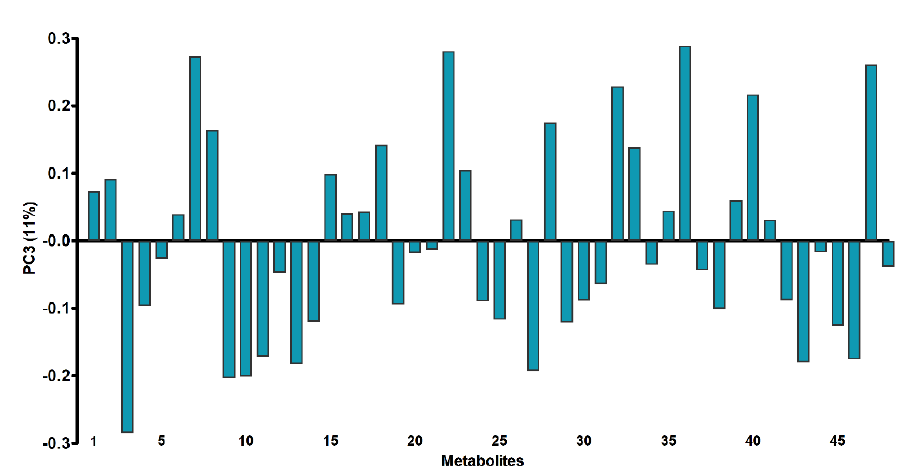
Figure 3. PCA results from the GC-MS data. Loadings plot of the third principal component (PC3) for the 48 metabolites (the number of each metabolite correlates with the identified metabolites as shown in Supplemental Table